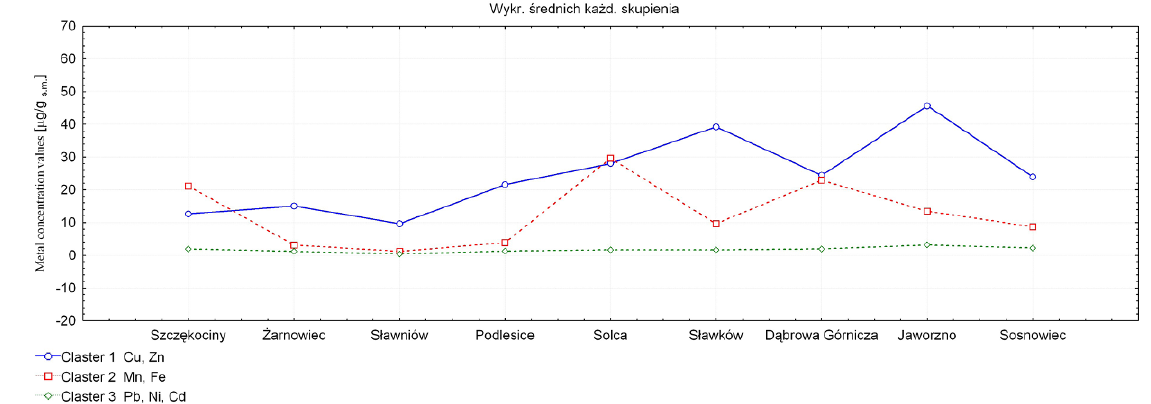
Figure 6. K-means analysis diagram for sampling locations assessed in terms of metal